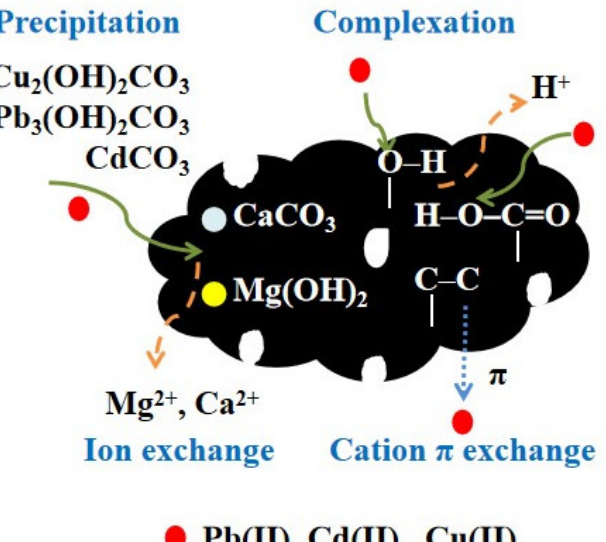
Figure 9. Schematic illustration of mechanisms for metal adsorption on 15%Mg-BC.